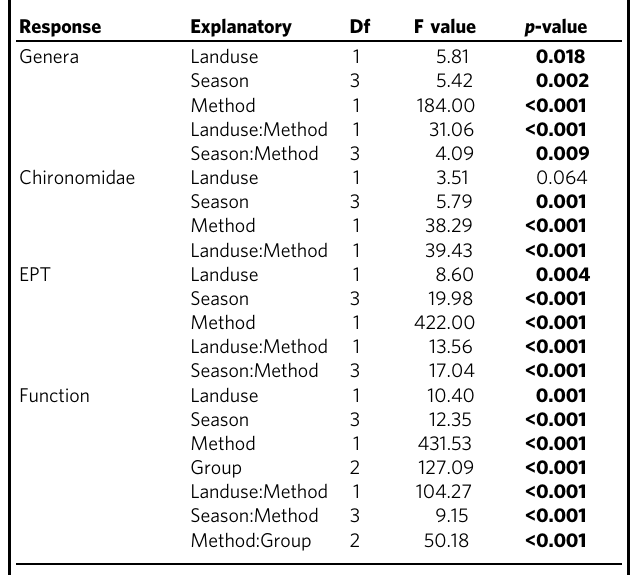
Results include each modeled genera, Chironomidae, EPT and functional richness response variable ( N = 112), tested against the set of explanatory variables; including landuse type, method (eDNA/traditional), season and the possible two-way interactions. The model includes a pairwise distance variance structure to account for spatial autocorrelation. Models shown are the most parsimoniousmodelswith the associatedmodelmetrics, includingdegrees of freedom (DF), f -value and p -value, given for each set of response and explanatory variables. P -values in bold indicate signi fi cant